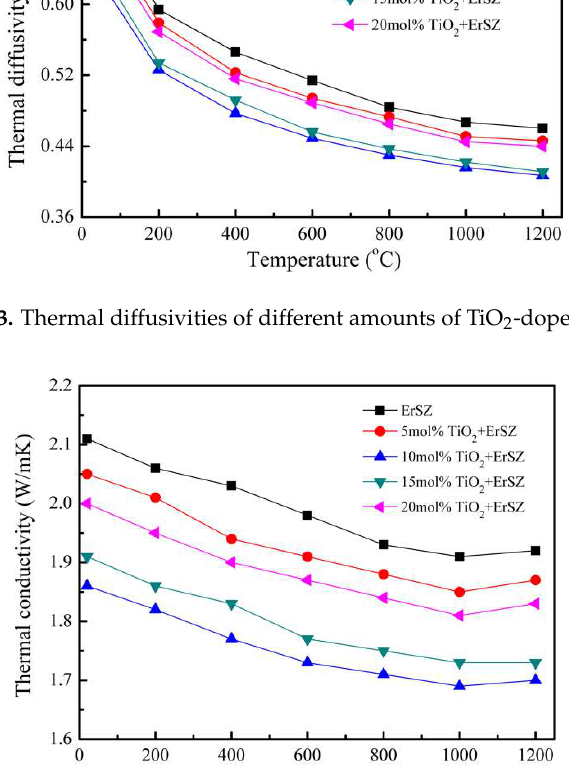
Figure 4. Thermal conductivities of different amounts of TiO 2 -doped ErSZ.